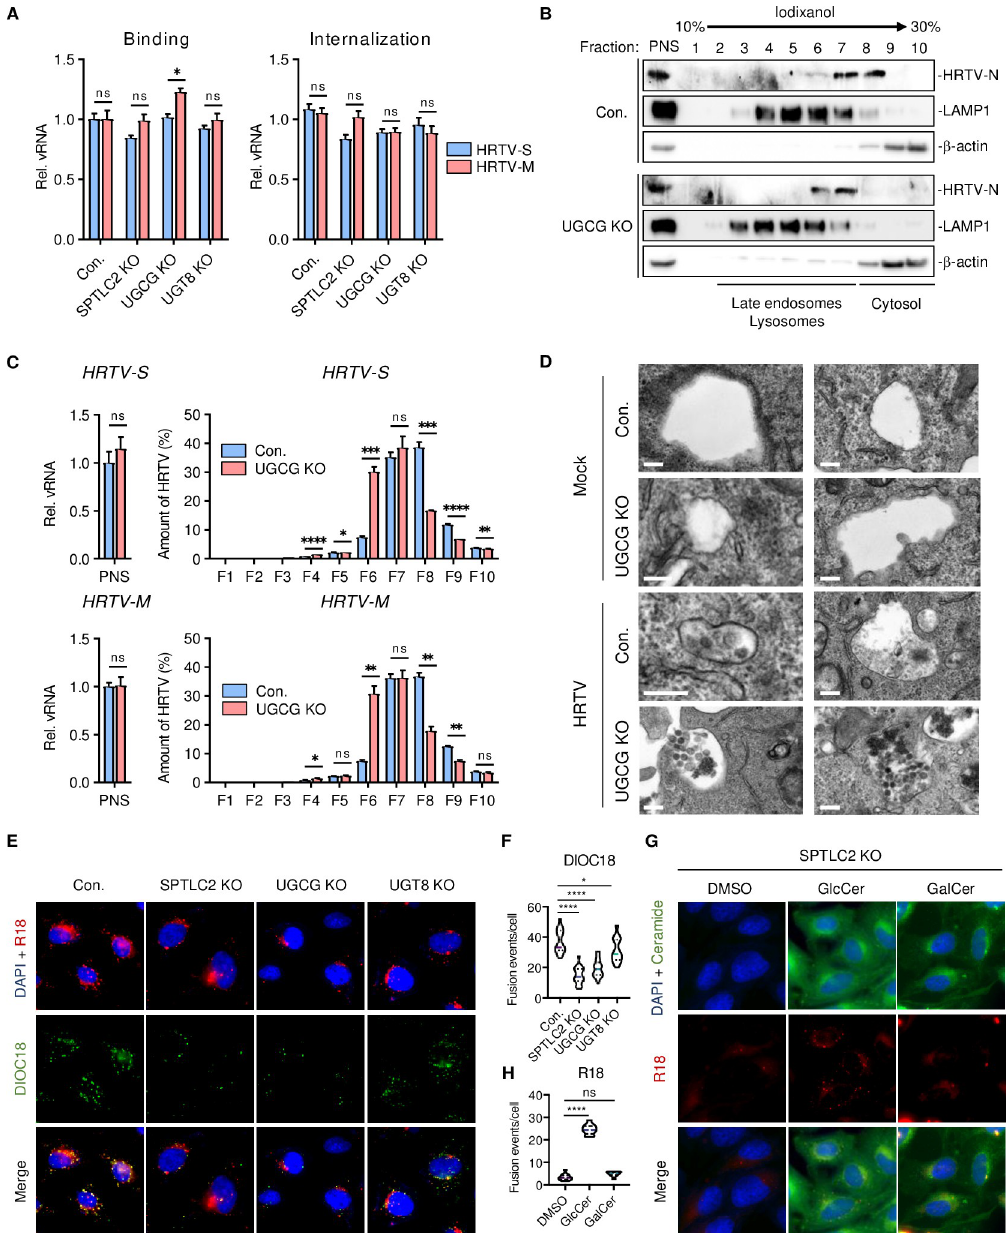
Fig 6. GlcCer is critical for HRTV-induced membrane fusion. A. Effect of SPTLC2-, UGCG- or UGT8-deficiency on HRTV binding and internalization. For binding assay, control and KO HeLa cells were incubated with HRTV particles at 4˚C for 1 hour. For internalization assay, after 4˚C incubation, cells were washed by PBS and then moved to 37˚C for additional 2 hours before qPCR assay. Data shown are means ± SEM from representative experiments (n = 3 technical replicates). P values were determined by multiple unpaired t-tests. � , P < 0.05. B-C. Subcellular fractionation of HRTV-infected control or UGCG-KO cells. Cells were treated as described in Materials and Methods, and the PNS was fractionated by Optiprep gradient centrifugation. PNS and each fraction were subjected to immunoblotting analysis with the indicated antibodies ( B ). Total RNAs were extracted from PNS and each fraction for qPCR assay ( C ). Data shown are means ± SEM from representative experiments (n = 3 technical replicates). P values were determined by multiple unpaired t-tests. ���� , P < 0.0001; ��� , P < 0.001; �� , P < 0.01; � , P < 0.05. D. Effect of UGCG-deficiency on HRTV trafficking. Control and UGCG-KO 293T cells were infected with HRTV at MOI = 50 for 4 hours. Cells were processed for thin-section electron microscopy according to standard procedures [47]. Bars, 200nm. E-F. Effect of SPTLC2-, UGCG- or UGT8-deficiency on HRTV-induced membrane fusion. HeLa cells were infected with DiOC18/R18-labeled HRTV for 30 min at 4˚C and then incubated at 37˚C for 2 hours ( E ). The numbers of fluorescent DiOC18 puncta were quantified by fluorescence microscopy ( F ). P values were determined